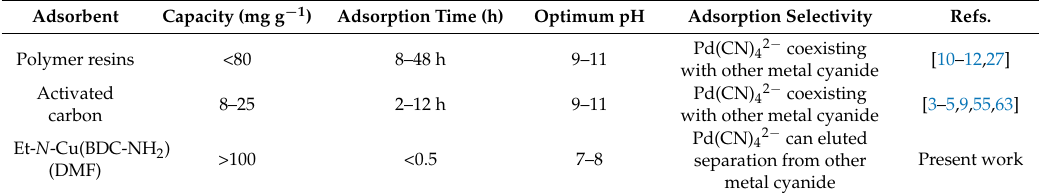
Table 7. Comparison of the maximum adsorption capacity, adsorption time, and adsorption selectivity for Pd(CN) 42- with polymer resins and activated carbon.